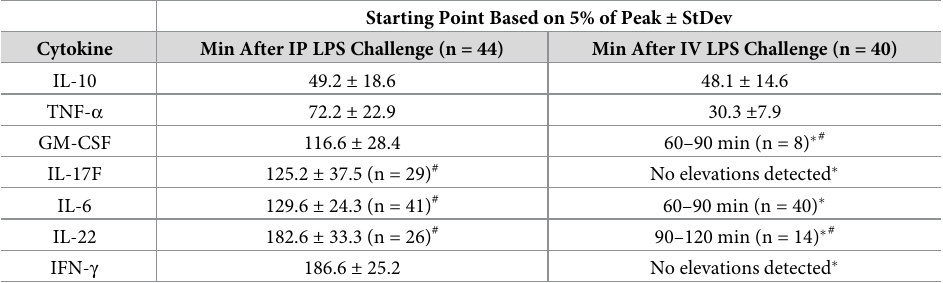
Table 2. Comparison of cytokine elevation starting points using IP vs IV injection